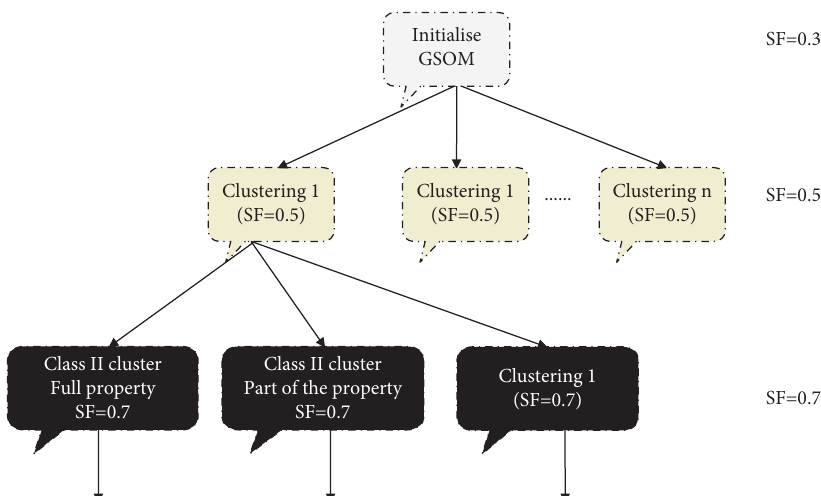
Figure 5: Hierarchical clustering based on the value of SF.